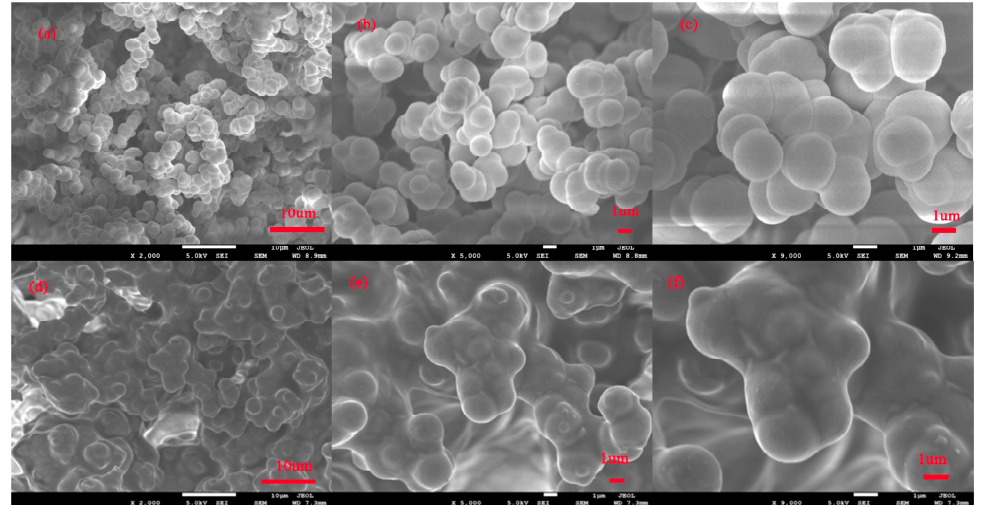
Figure 1. Scanning electron microscopy (SEM) images of PF ( a – c ) and ASO-PF ( d – f ) xerogels.